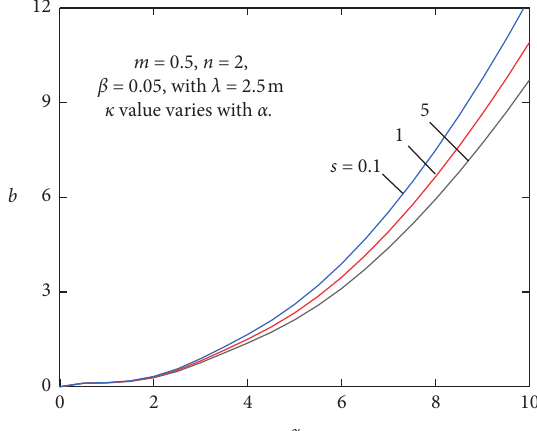
Figure 6: Dependence of the dimensionless buckling load b on the dimensionless characteristic length α , for different friction ratios s